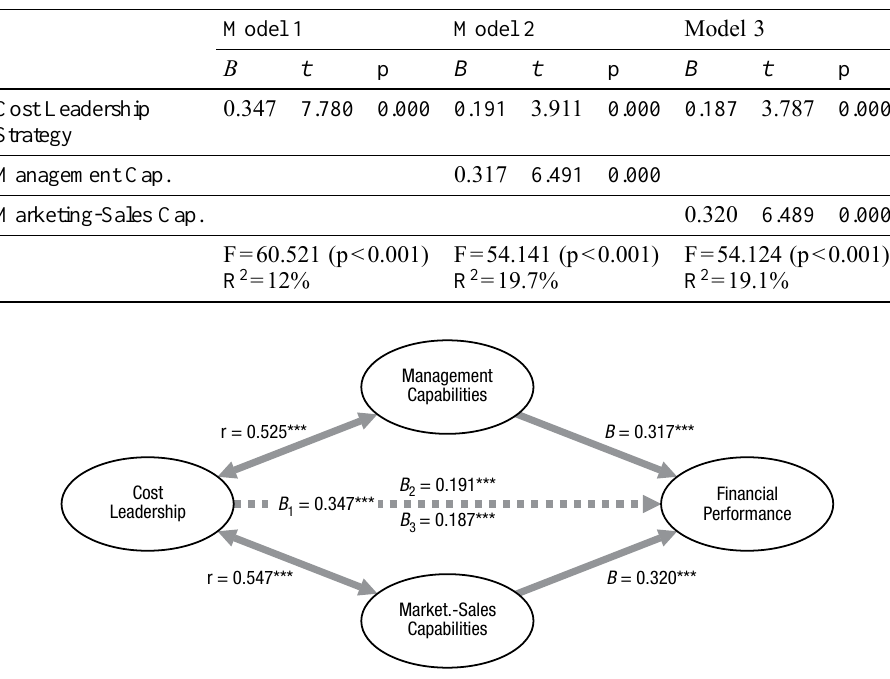
Fig. 1. The mediating effects of management and marketing-sales capabilities on the relationship between cost leadership strategy and financial